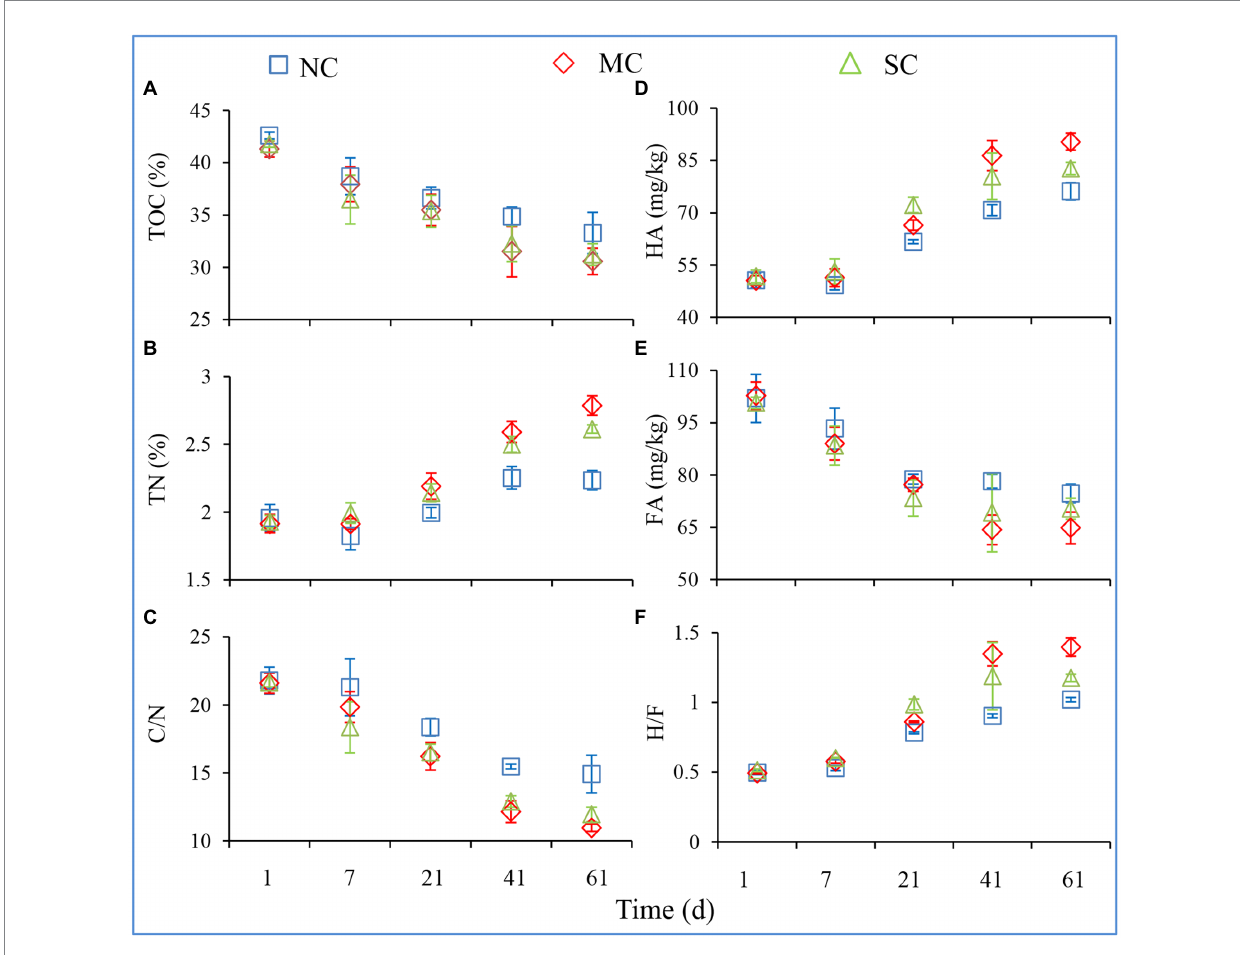
FIGURE 1 Changes in physicochemical characteristics during the composting process. TOC (A) , TN (B) , HA (D) , and FA (E) denote the total organic carbon, total nitrogen, humic acid, and fulvic acid, respectively. C/N (C) and H/F (F) denote the TOC-to-TN ratio and HA-to-FA ratio, respectively. The error bars represent the standard deviations of the